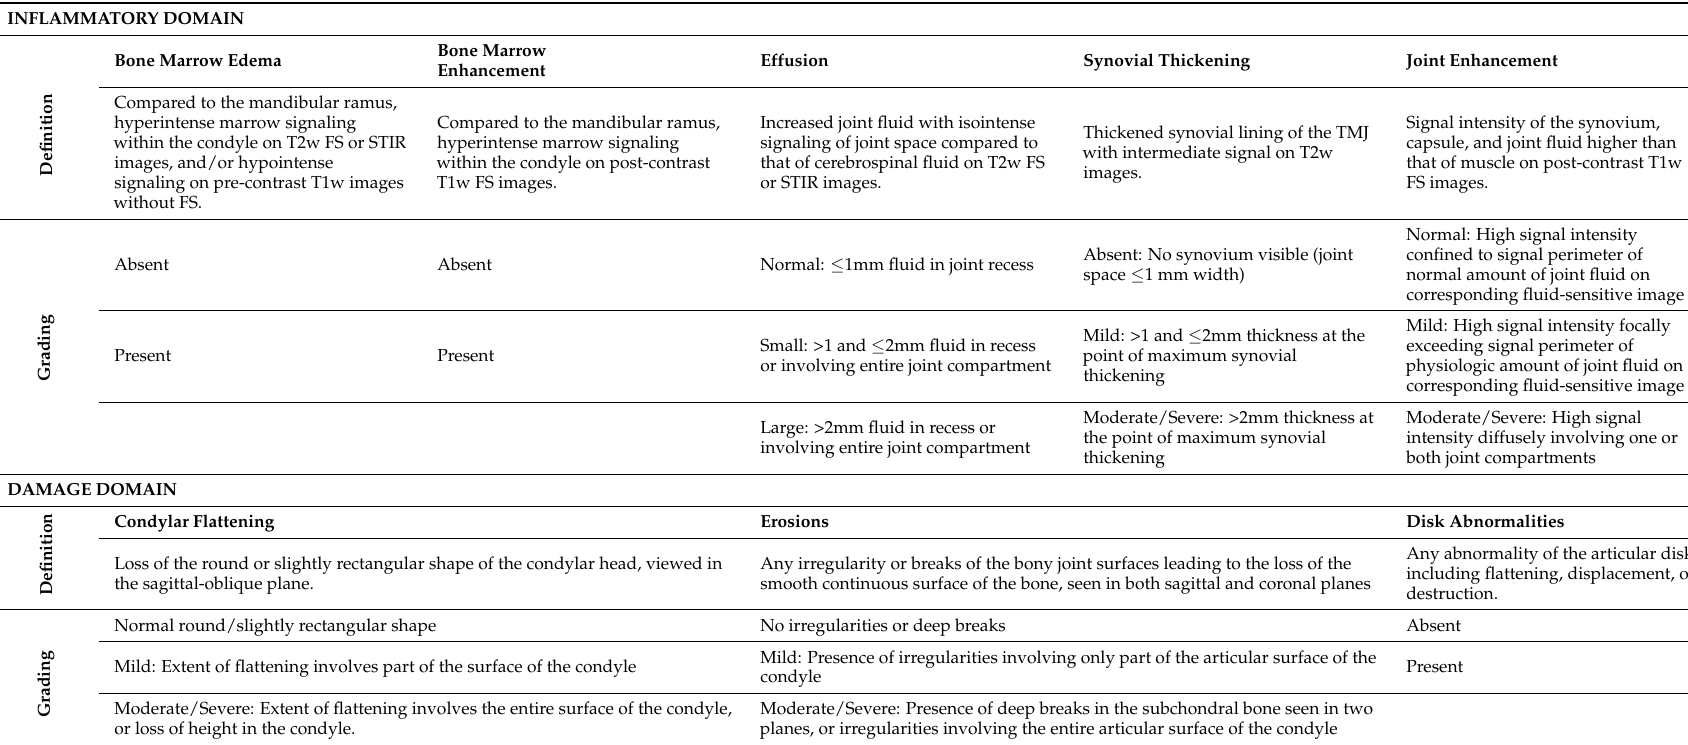
Table A1. The scoring system tested in the exercise is referred to as the Juvenile Idiopathic Arthritis Magnetic Resonance Scoring System for Temporomandibular Joints (JAMRIS-TMJ). The semiquantitative grades are weighted per domain to yield domain scores which are scaled from 0–100% [17]. The two temporomandibular joints are graded